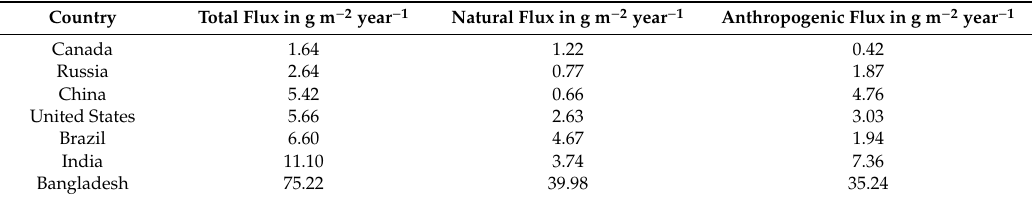
Table 2. Annual methane fluxes from di ff erent countries, calculated using country-specific emission data from